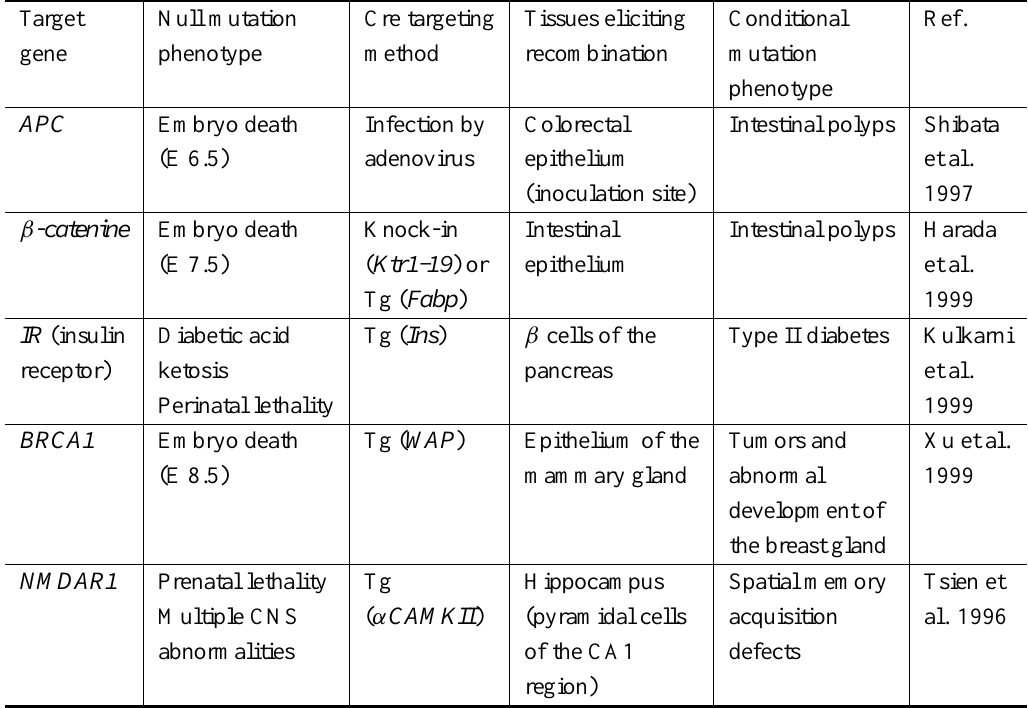
Some examples of